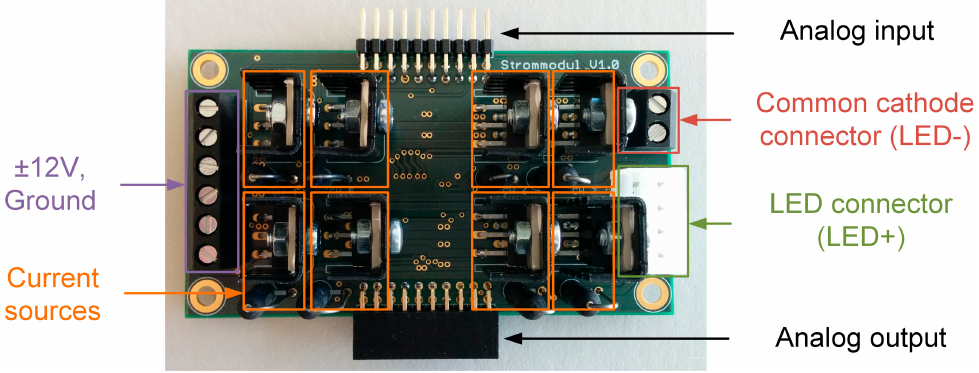
Figure 6. Top view of the current module.